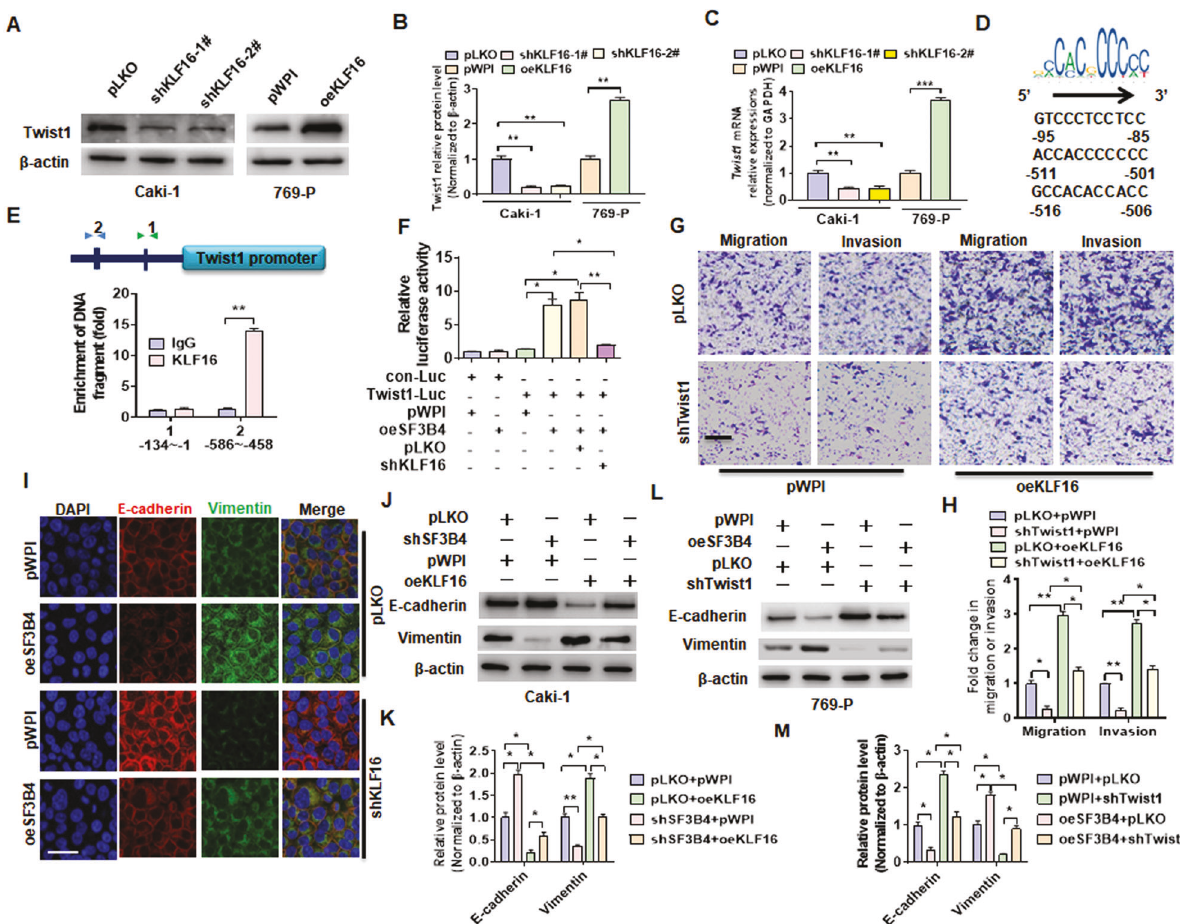
Fig. 7 Upregulation of Twist1 by KLF16 mediates the promoting effect of SF3B4 on ccRCC progression. A – C Caki-1 and 769-P cells were transfected with indicated constructs, and then western blot and RT-qPCR detected Twist1 expression. D The potential KLF16-binding motif on the proximal promoter of Twist1 gene. E ChIP-PCR was used to verify the binding site of KLF16 on the Twist1 promoter. F Dual-luciferase reporter gene examined the role of SF3B4 and KLF16 in regulating Twist1 promoter activity by co-transfection with indicated constructs. G , H Caki-1 cells were transfected with shTwist1 and oeKLF16, alone or together, and then transwell assay was used to examine cell migration and invasion. Scale bar = 50 μ m. I The expression of E-cadherin and vimentin were detected by double immuno fl uorescence staining in cells transfected with indicated constructs. Scale bar = 20 μ m. J , K Caki-1 cells were transfected with shSF3B4 and oeKLF16, alone or together, and then the expression of EMT-related genes was detected by western blot. L , M 769-P cells were transfected with oeSF3B4 and shTwist1, alone or together, and then the expression of EMT-related genes was detected by western blot. All data are expressed as the mean ± SEM of three independent experiments. * P < 0.05, ** P < 0.01, *** P < 0.001 vs. their corresponding